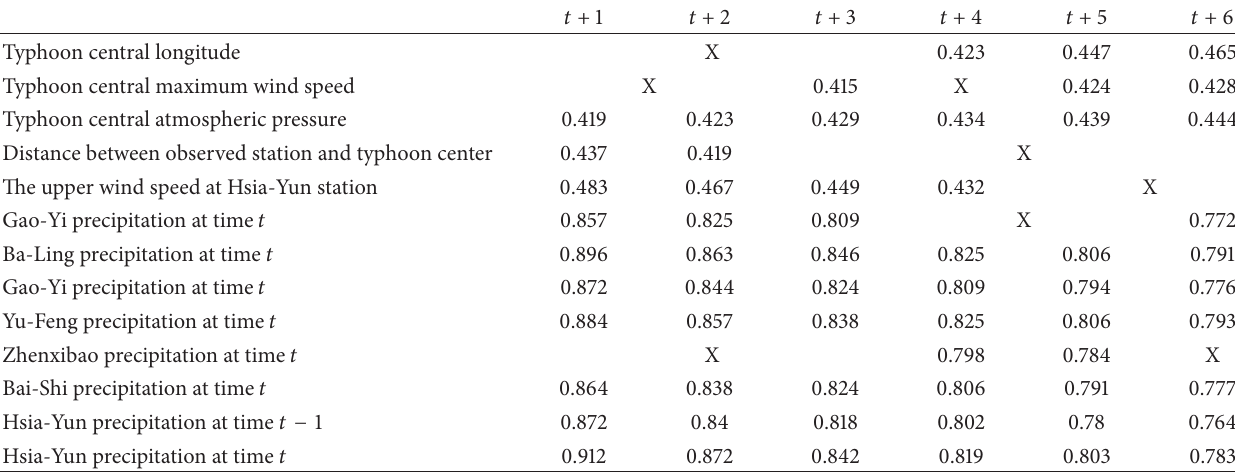
Table 3: The selected model inputs and corresponding correlation coefficients for Hsia-Yun station.